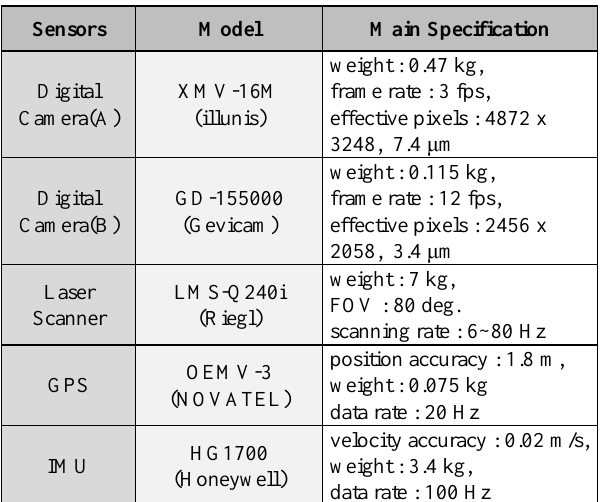
Table 1. Model and main specifications of the sensors